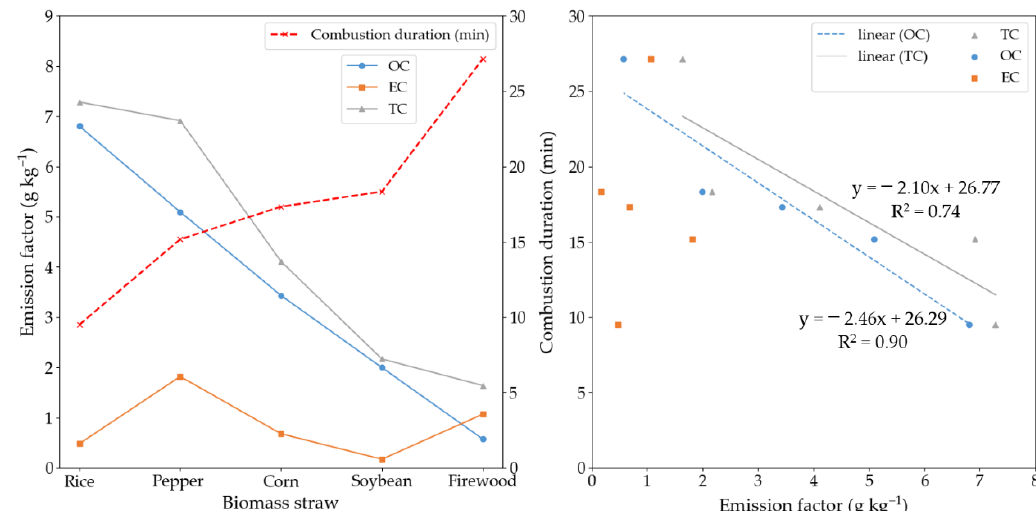
Figure 3. ( a ) Emission factors for OC, EC, and TC from the five types of biomasses, and ( b ) combustion durations for the five types of biomasses.